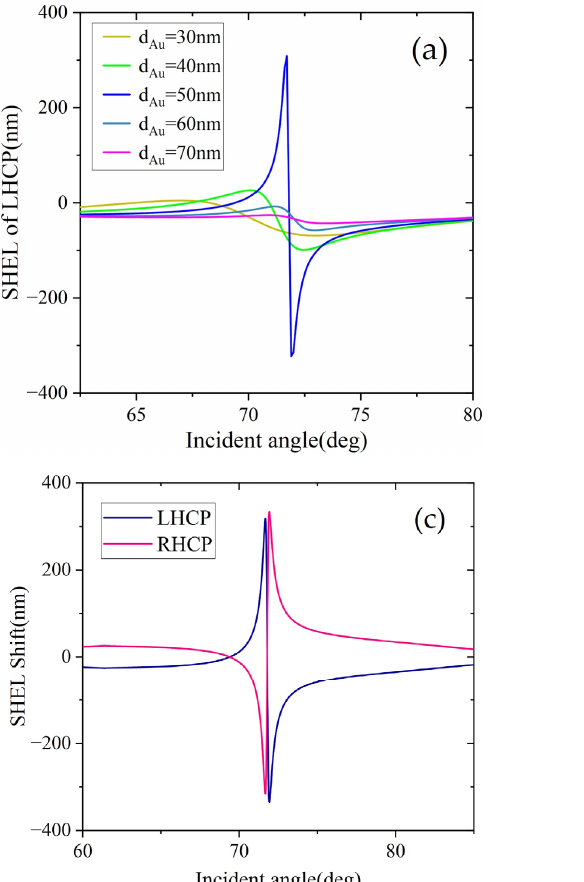
Figure 3. ( a ) Variation of SHEL shift of LHCP component with the incident angle at different thicknesses of gold layer; ( b ) variation of SHEL shift of RHCP component with the incident angle at different thicknesses of gold layer; ( c ) variation of SHEL shift versus incident angle when the thickness of gold layer was 50 nm; ( d ) Variation of reflection coefficient R versus incident angle when the thickness of gold layer was 50 nm.